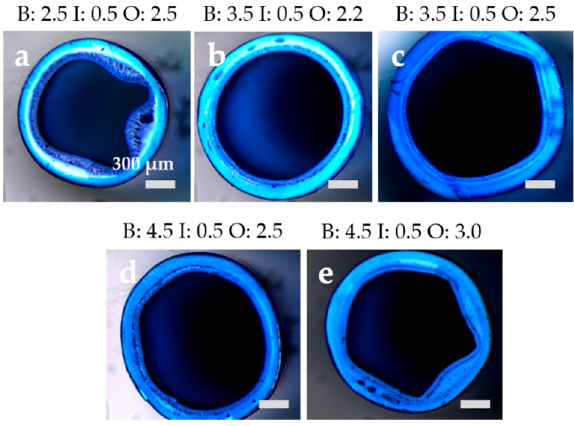
Figure 15. A selection of spinning parameters (bore (B) and outer (O) flow rates varied, while keeping the inner (I) flow rate) and resulting morphologies of DLHF AS 9. For better visibility of the porous structure in light microscopy, the fibers were dipped into 1% methylene blue in ethanol.